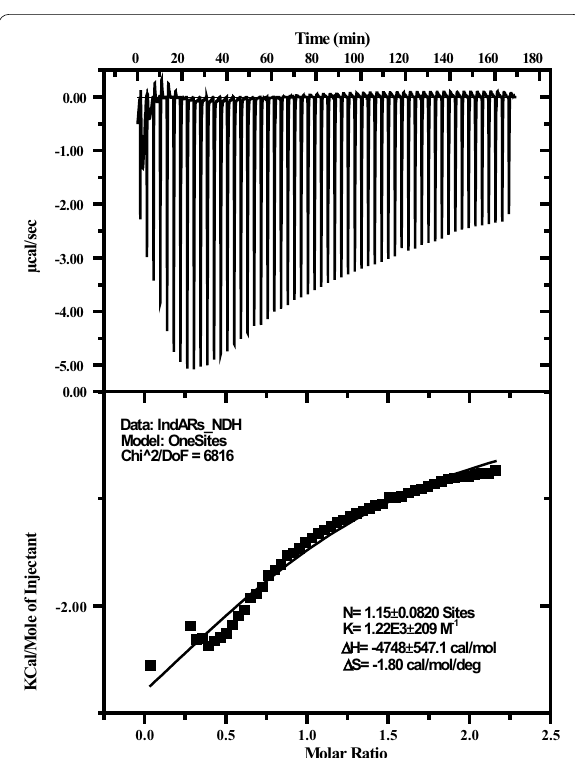
0.0 Fig. 6 ITC data for binding isotherm for interaction between In-ARS complex and F at 313 K (normalization was done with heats per peak ¯ as a function of molar ratio in the calorimetric